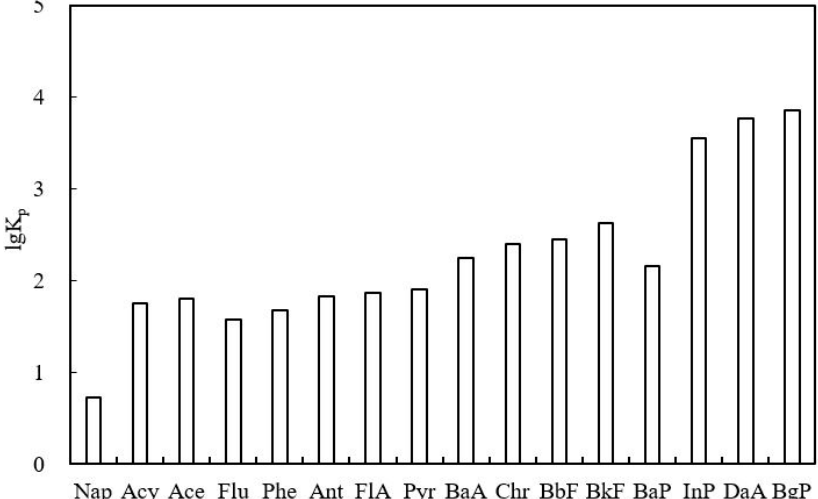
Figure 6. Partitioning coefficients of PAHs in sediment–water interface of underground river.